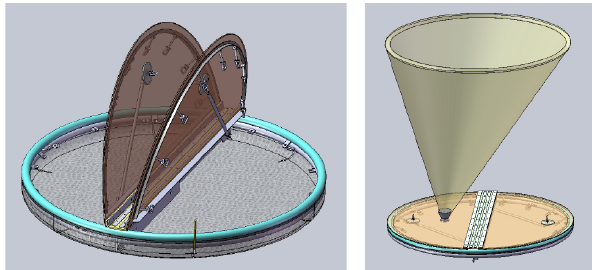
Fig. 3. Sketches of bottom plate. Left: lids in upright position, as 3 applied during filling of the enclosure bags. A removable net (grey shaded area) with a mesh size of 3mm is mounted below the bottom ring. Each bottom plate is equipped with 8 screws for tightening the lids after closing. Right: bottom plate in closed position with unfolded sediment trap.